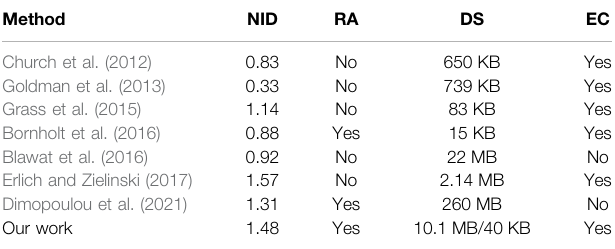
TABLE 2 | Comparison of existing encoding schemes.